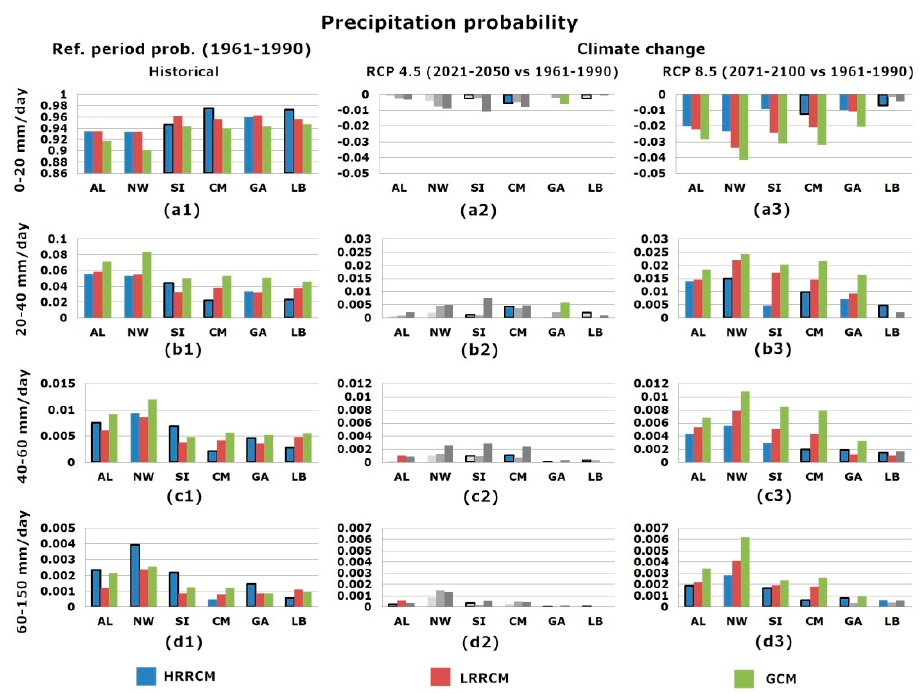
Figure 7. Probability of daily precipitation (from 0 to 1) as function of intensity range and its variation with climate change. All values are computed under the condition of day being a wet day. Four ranges of intensity are considered in the di ff erent rows: weak (0–20 mm / day), medium (20–40 mm / day), strong (40–60 mm / day) and intense (above 60 mm / day). Panels ( a1 – d1 ) (first column) show the probability of rain for the reference period (1961–1990). ( a2 – d2 ) Second and ( a3 – d3 ) third columns show the probability change for the RCP4.5 (near-term, 2021–2050) and RCP8.5 (long-term 2071–2100) scenarios with respect to the reference period (1961–1990). Grey bars denote di ff erences that are not statistically significant. A bold border of blue bars denotes di ff erences between HRRCM and LRRCM that are statistically significant.